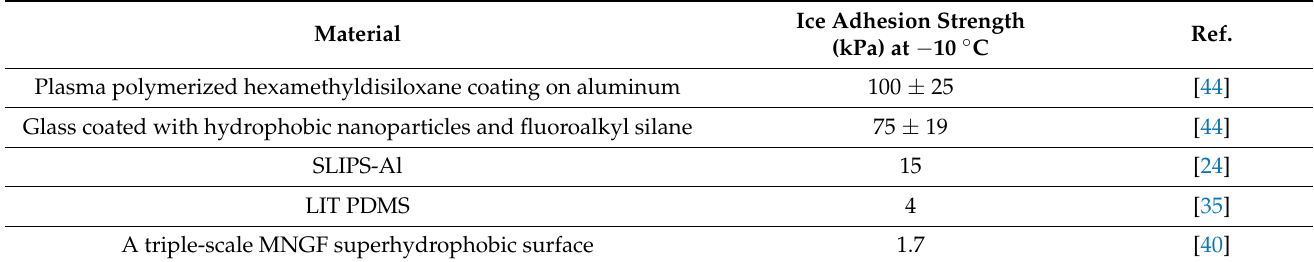
Table 1. Comparison of ice adhesion